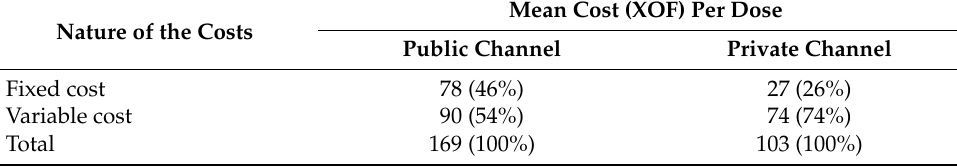
Table 3. PPR vaccination cost by inputs.